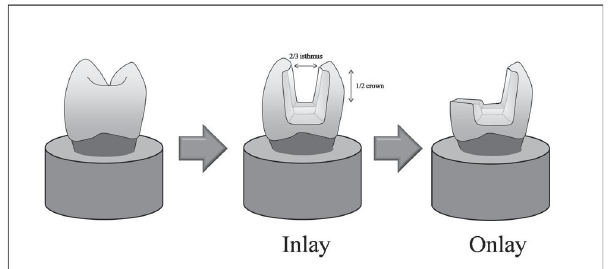
Fig.1. Inlay and onlay cavity